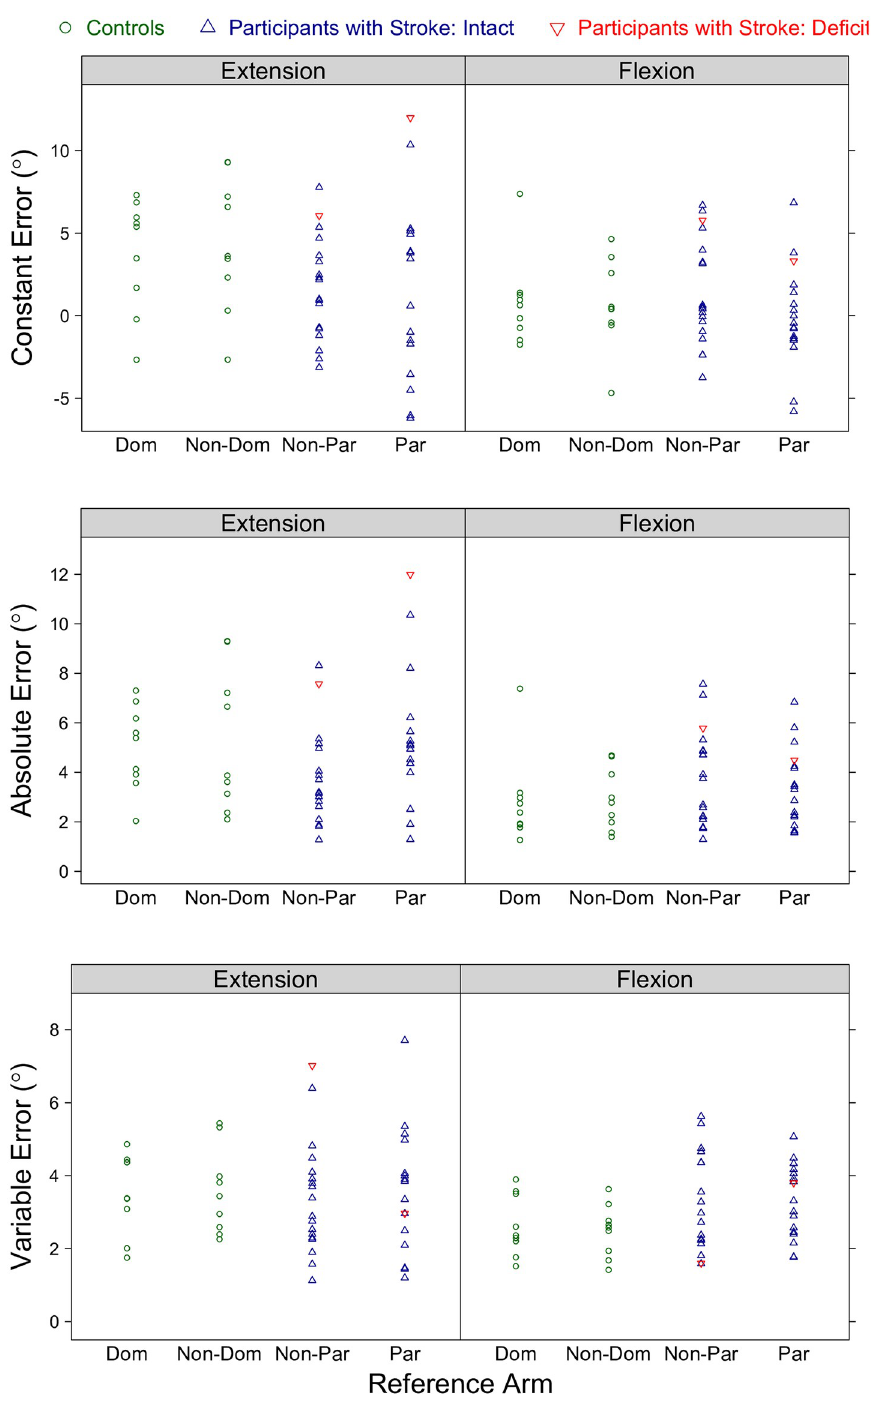
Fig 2. Single-arm position-matching results for each participant across all tested conditions. Shown are the robotic assessment results on the single-arm position-matching task for the controls and participants with stroke. Each participant’s (Top) constant error, (Middle) absolute error, and (Bottom) variable error are given as a function of the reference arm and reference target location. (Dom: dominant, Non-Dom: non-dominant, Non-Par: non-paretic, Par: